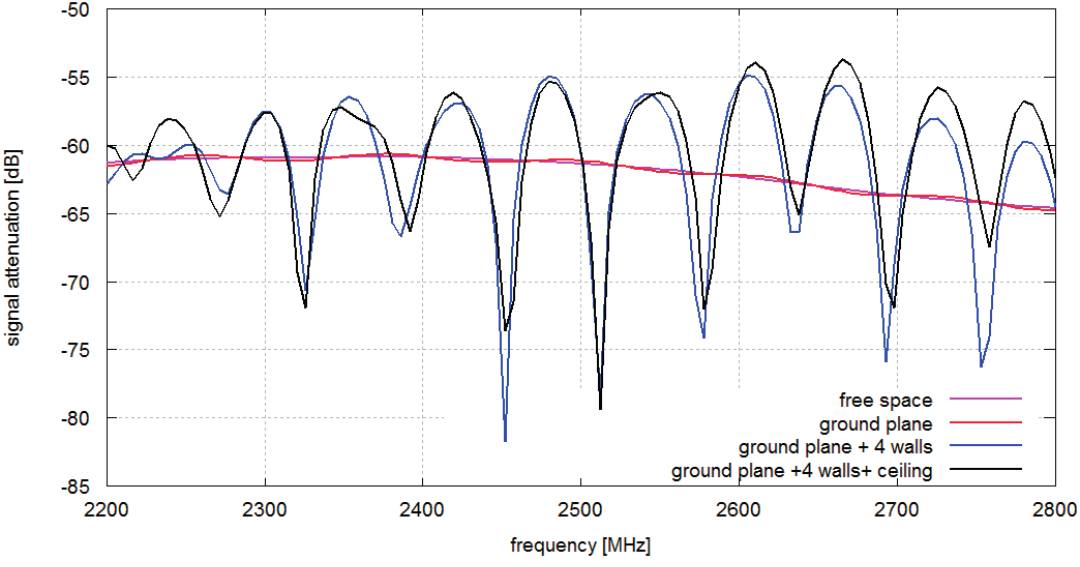
Figure 4. Simulated signal attenuation vs. frequency: A pair of antennas located on the chest and on an arm (1–3) simulated for different propagation environments comprising gypsum walls.